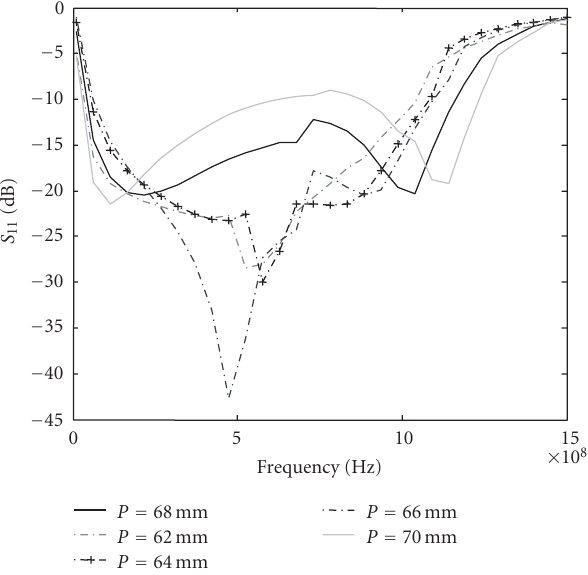
Figure 5: E ff ect of varying P to the antenna characteristic.